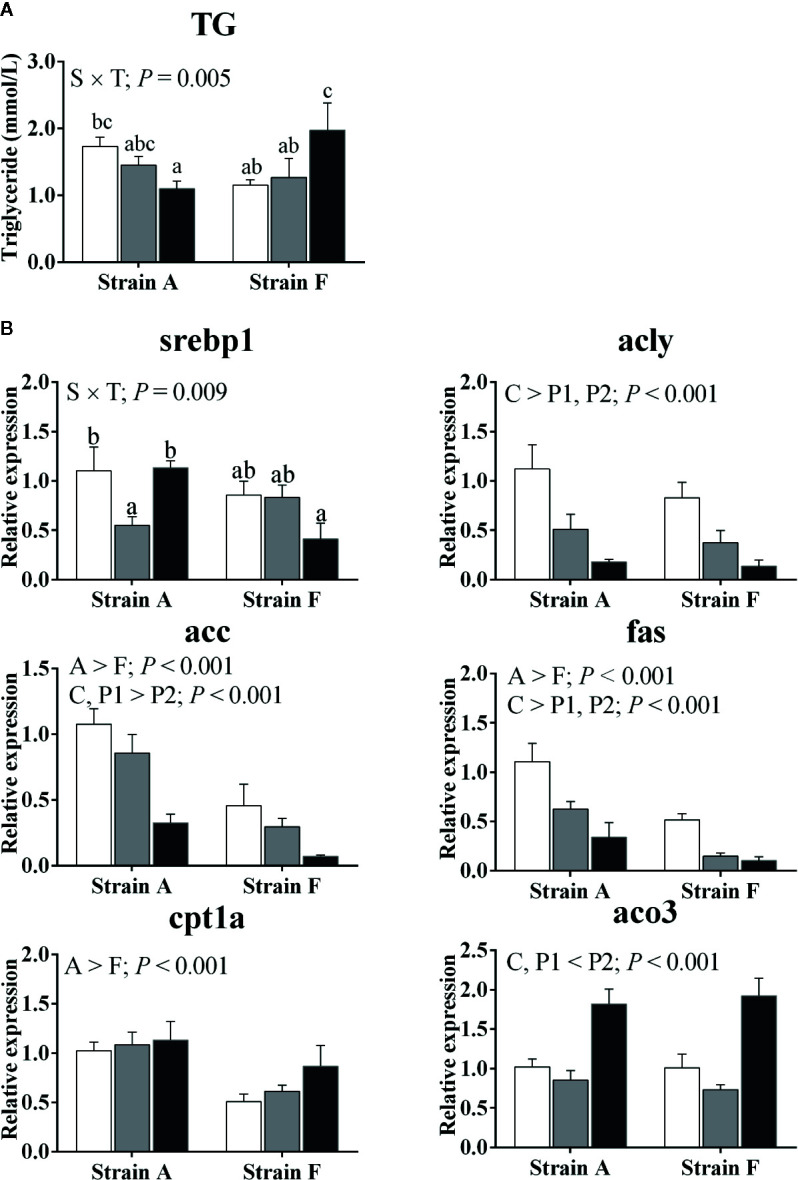
Plasma triacylglycerol levels (A) and expression of genes related to lipid metabolism in the livers (B) of two strains of gibel carp starved for 0 days (C, white bars), 38 days (P1, gray bars), and 77 days (P2, black bars) during winter. Data are presented as mean ± SE (n = 6), and the differences were evaluated by two-way ANOVA (P < 0.05). When interactions were identified, different lowercase letters represented the significant differences among all groups (P < 0.05). TG, triacylglycerol; srebp1, sterol regulatory element binding protein 1; acly, ATP citrate lyase; acc, acetyl-CoA carboxylase; fas, fatty acid synthase; cpt1a, carnitine palmitoyl transferase 1 isoform a; aco3, acyl-CoA oxidase 3.